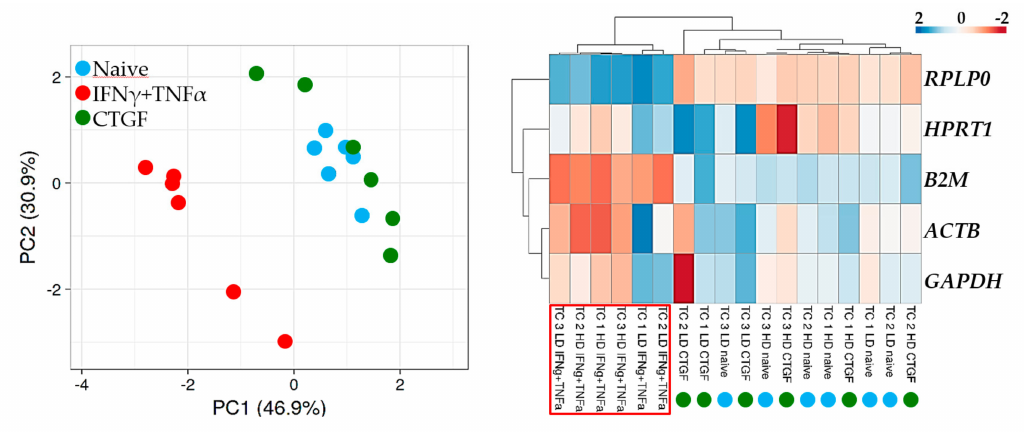
Figure 3. Principal component analysis (PCA) and heat map of RG expression values. In PCA, the X - and Y -axis show principal component 1 and principal component 2 that explain 46.9% and 30.9% of the total variance, respectively. In the heatmap, positive values mean higher Cts, and negative values mean lower Cts with respect to mean values after row centering for each RG, indicating lower (high CTs) or higher (low Cts) basal expression, respectively. Both rows and columns were clustered using correlation distance and average